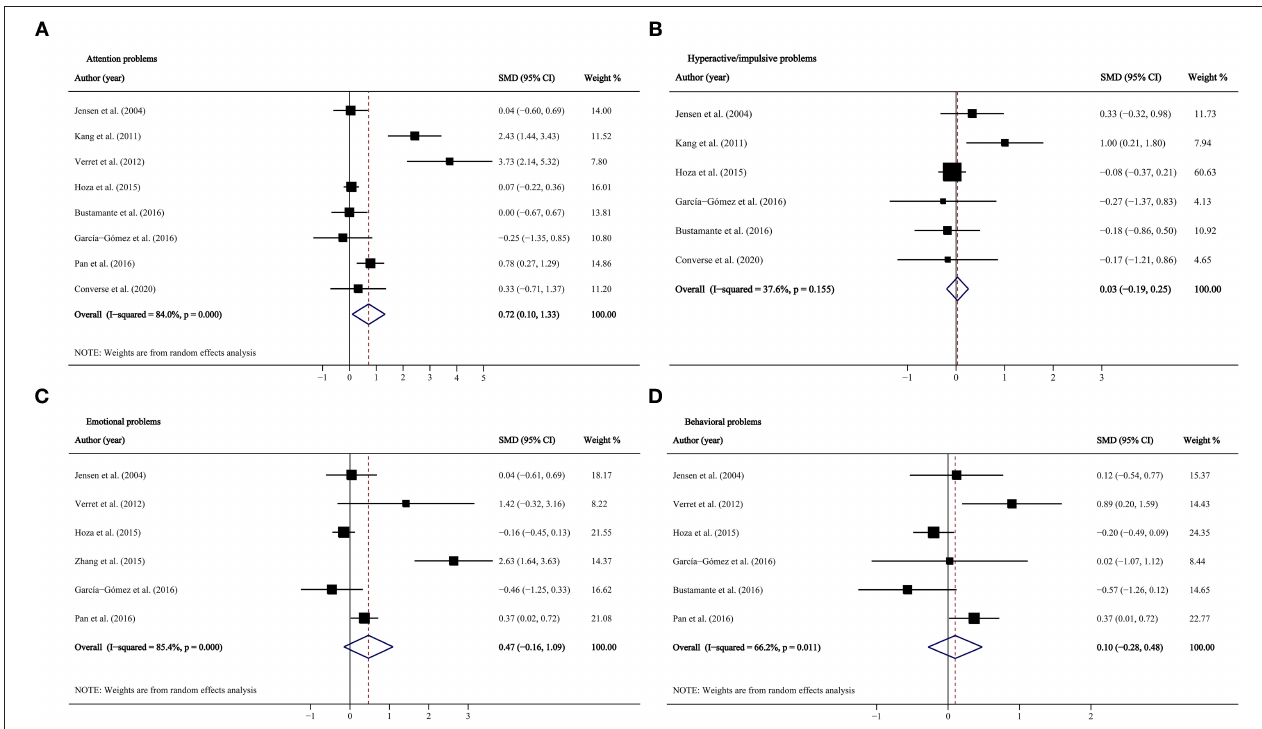
FIGURE 3 | Forest plots for physical activity intervention on ADHD symptoms in two-group control studies. (A) Attention problems; (B) hyperactive/impulsive problems; (C) emotional problems; (D) behavioral problems. CI, confidence interval; SMD, standardized mean difference.